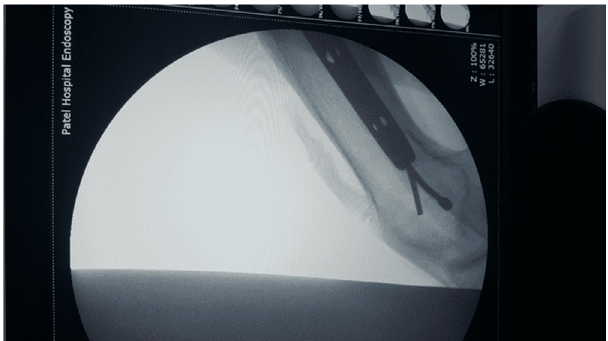
Figure 4. Both wires (Plain & Ball tipped) protruded through the broken portion of the nail.